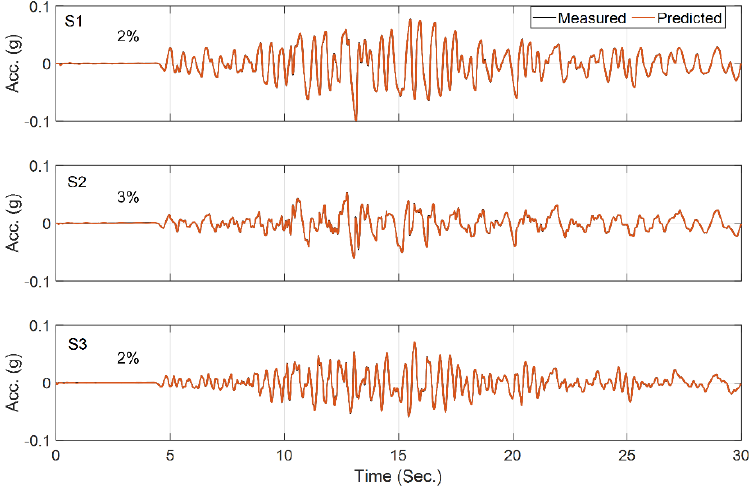
Figure 13. Comparison between the measured and predicted acceleration responses in Case Study 4.